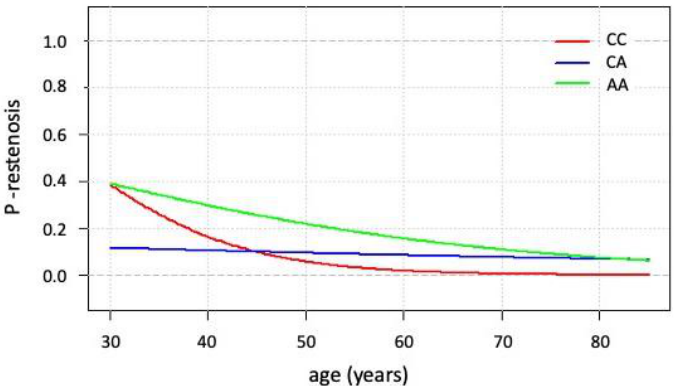
Figure 1. Logistic regression modeling estimating the presence of restenosis (dependent variable) for individual genotypes and ages (independent variables). A more detailed explanation can be found in the text.